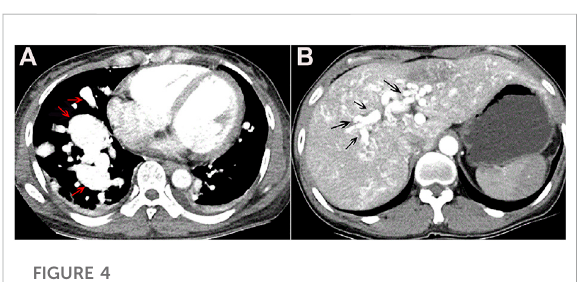
FIGURE 4 (A) Chest-enhanced CT image in the arterial phase showed multiplevascular massesinbilaterallungs,mainlyinthelowerlobe of the right lung, suggesting pulmonary arteriovenous fi stula (red arrow). (B) Epigastrium-enhanced CT showed multiple hepatic arteriovenous malformations (black arrow).